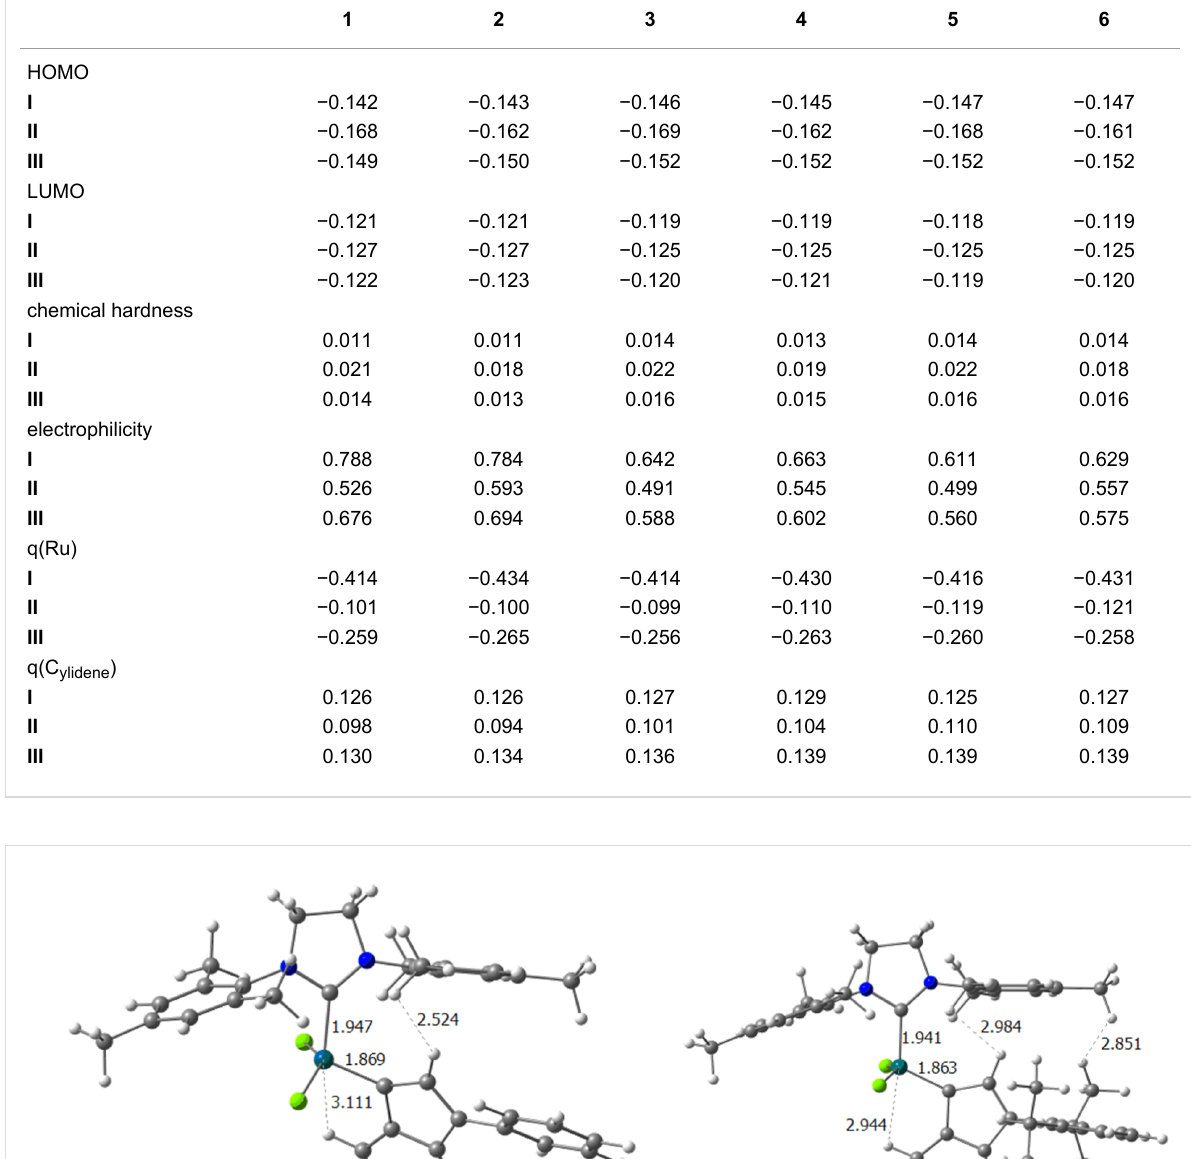
Table 3: Electronic analysis for species I – III for catalysts 1 – 6 (in kcal/mol) including energies of the frontier molecular orbitals (HOMO and LUMO); conceptual DFT parameters such as chemical hardness and electrophilicity; and natural population analysis (NPA) charges on ruthenium and ylidenic carbon.